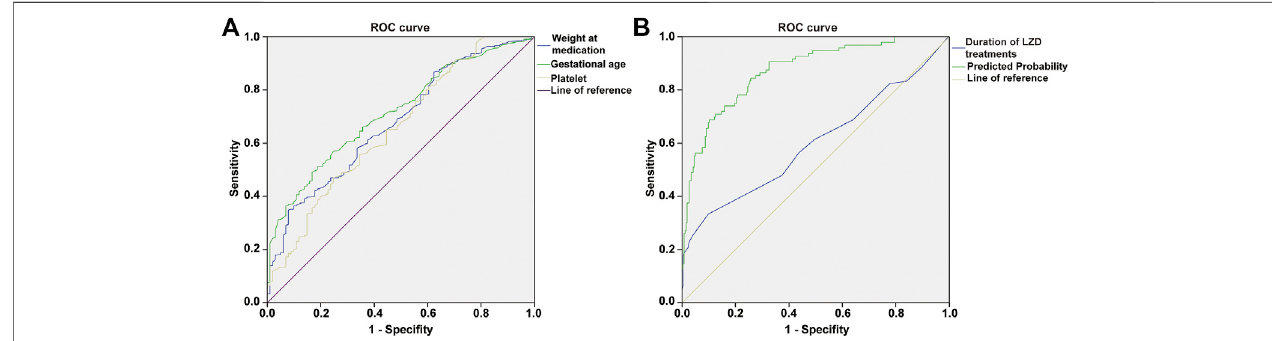
Frontiers in Pharmacology |